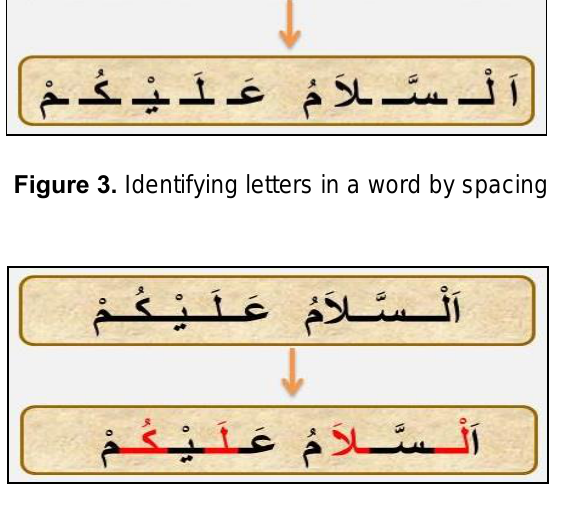
Figure 4. Identifying letters in a word by